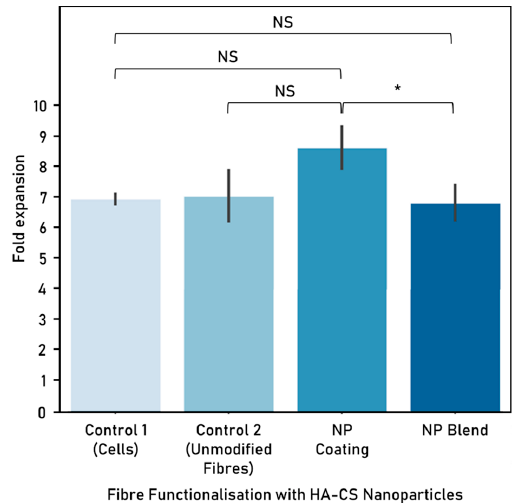
Figure 14. Cell proliferation (fold expansion) after 72 h co-culture with hyaluronic acid-chitosan nanoparticles (mean ± standard deviation). HA-CS nanoparticle concentration: 1 × 10 − 2 mg/mL. Cell seeding number: 300,000 cells, 6-well plate used, controls: cells-only (control 1) and unmodified fibres (control 2). Fibres were electrospun from a polycaprolactone-gelatine (70:30 PCL:Ge solution ratio) polymer, at 8% w / v initial PCL or Ge in solvent. Electrospinning parameters—time: 300 s, solvent: TEF, voltage: 10 kV, distance between nozzle and collector: 15 cm. Significant (*) and nonsignificant (NS) differences between samples are shown (ANOVA/Tukey, p < 0.05; n = 3).